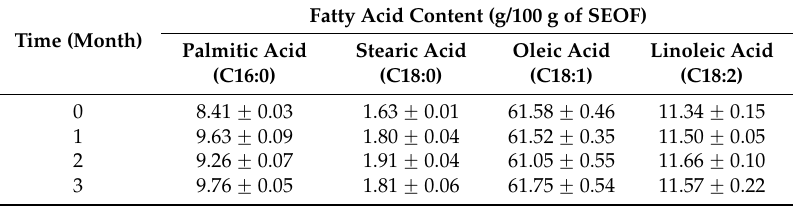
Table 3. The amount (g/100 g sample) of each fatty acid obtained from SEOF over the times (0, 1, 2, 3 months) at 30 °C.